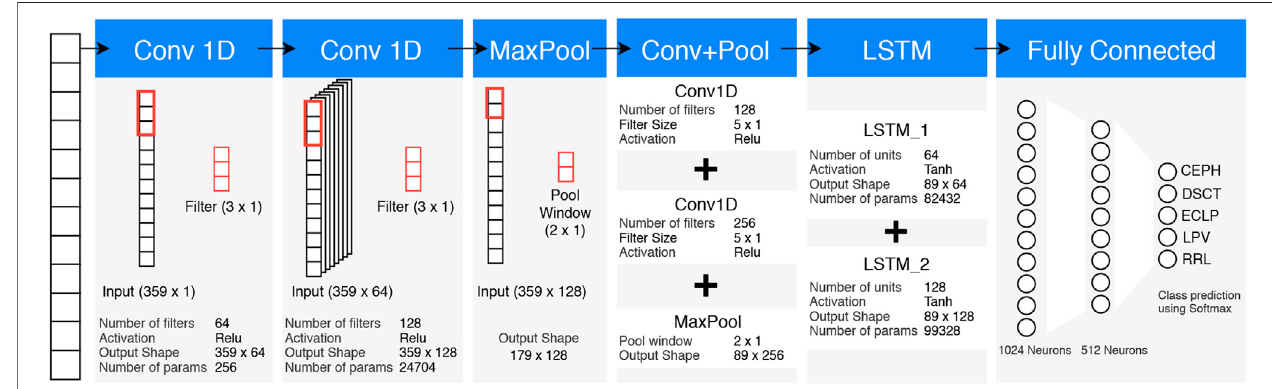
FIGURE4| Schematicdiagram showingthearchitectureof1DCNN-LSTM modelfortheOGLEdataset. Theinputsequencesarepaddedwithzeroestomaintain theconstantlengthof359intheOGLEsurveyand546intheCRTSsurveyforalllightcurves.Eachblockrepresentdifferenttypeoflayersasindicatedbytheheader.The samearchitectureisusedfortheCRTSdatasetexceptthe fi nalclassi fi cationlayerwhichinsteadcontainssevennodescorrespondingtosevenvariabilityclassespresent in the